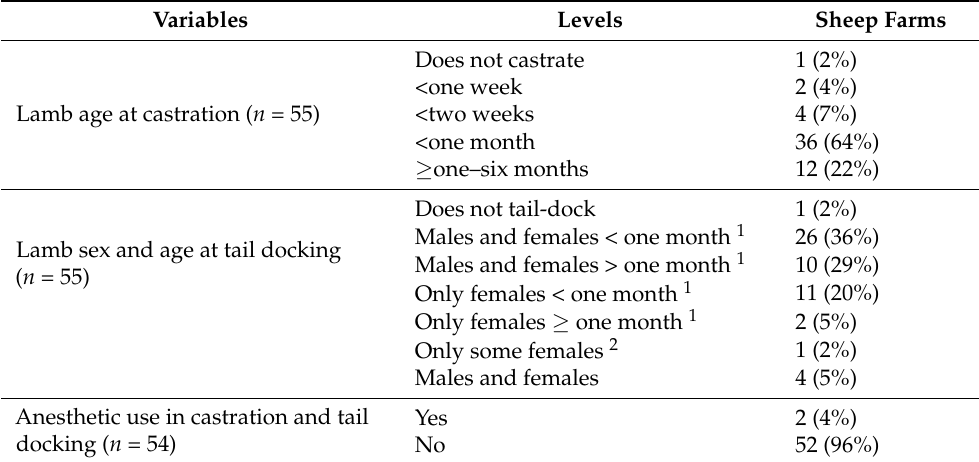
Table 2. The management of sheep castration and tail docking by 56 farmers in a southwest town in the State of Rio Grande do Sul, Brazil, from September 2017 to December 2017. Variables Levels Sheep Farms Does not castrate 1 Lamb age at castration ( n = 55)